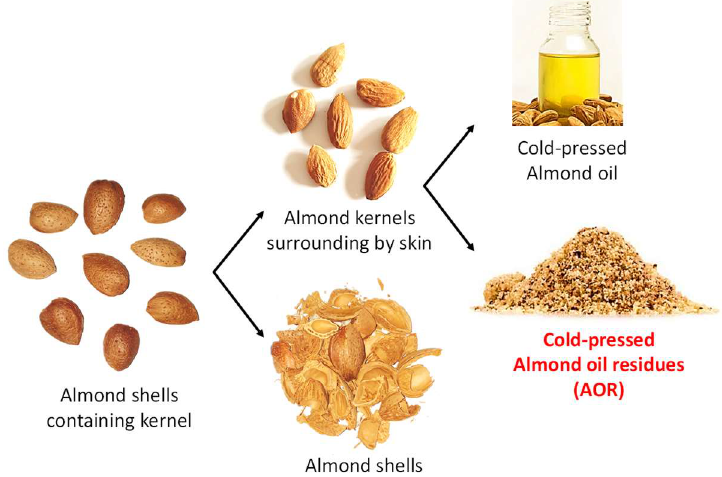
Figure 1. Parts of almond fruits leading to cold-pressed almond oil and its residue (AOR) used as byproduct in the present study to extract phenolic compounds.